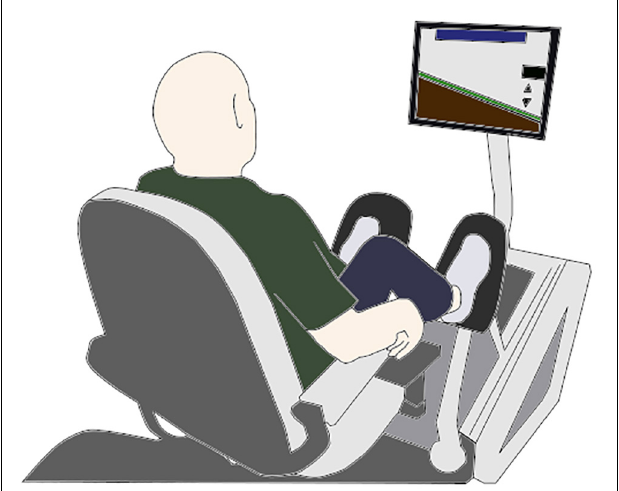
FIGURE 1 | Eccentron machine illustration, a multi-joint eccentric RT approach. The machine uses a motor to drive the pedals toward the subject, unilaterally in an alternating manner. The force level produced by the subject is viewed in real time on a computer simulation, which presents a target for the subject to attempt to reach with each repetition. The movement primarily involves the muscles surrounding the knee and hip joints, and to a lesser degree the